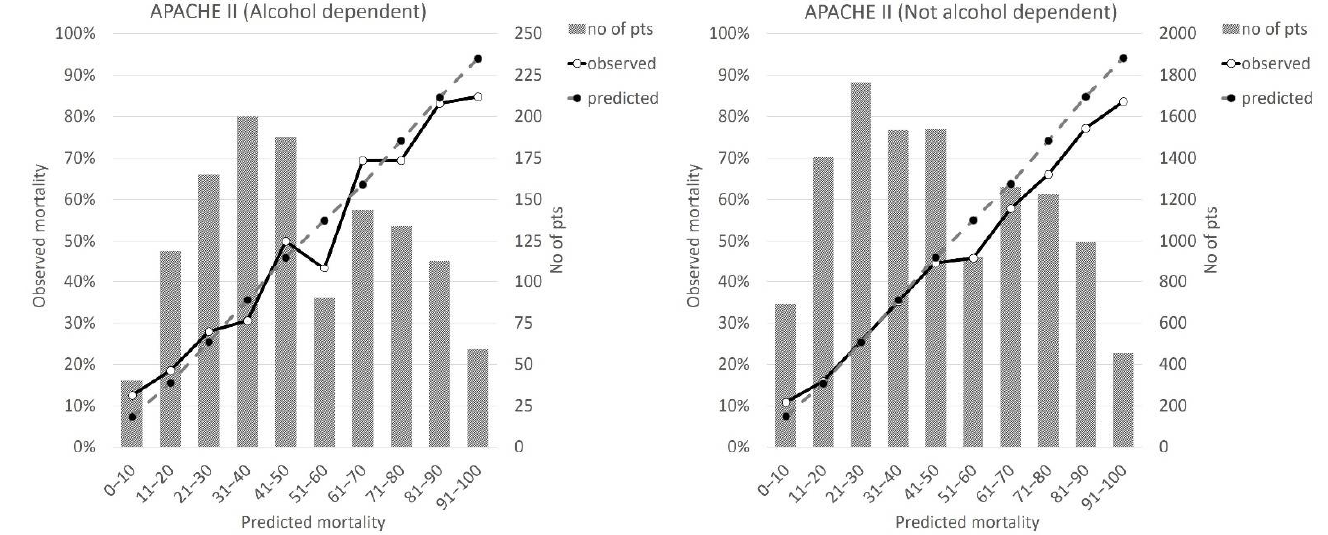
Figure 3. Expected and observed mortalities across various ranges of APACHE II scoring results in patients with and without AD (patients with AD—( left figure ), patients without AD—( right figure )).